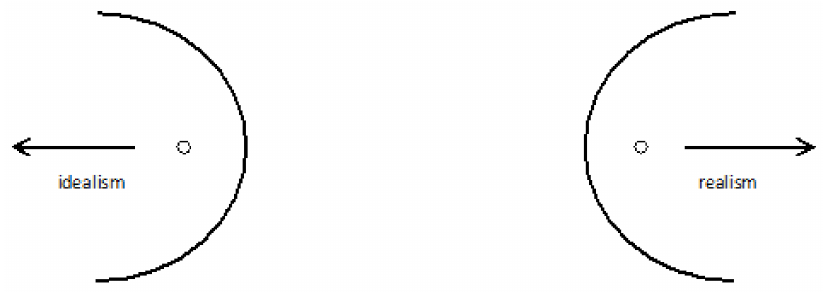
Figure 2. Tension between the focus on realism vs. idealism [94].